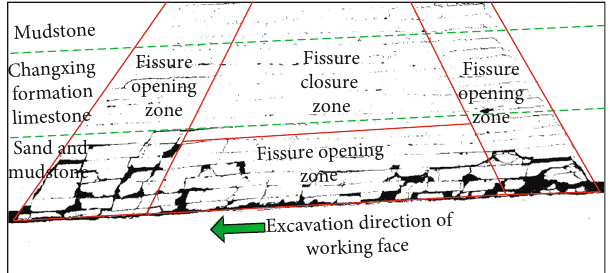
Figure 4: Fissure fi eld in mining 4# coal